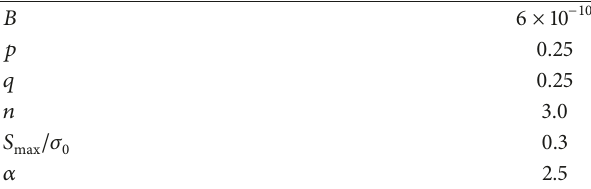
Table 2: Crack growth properties of